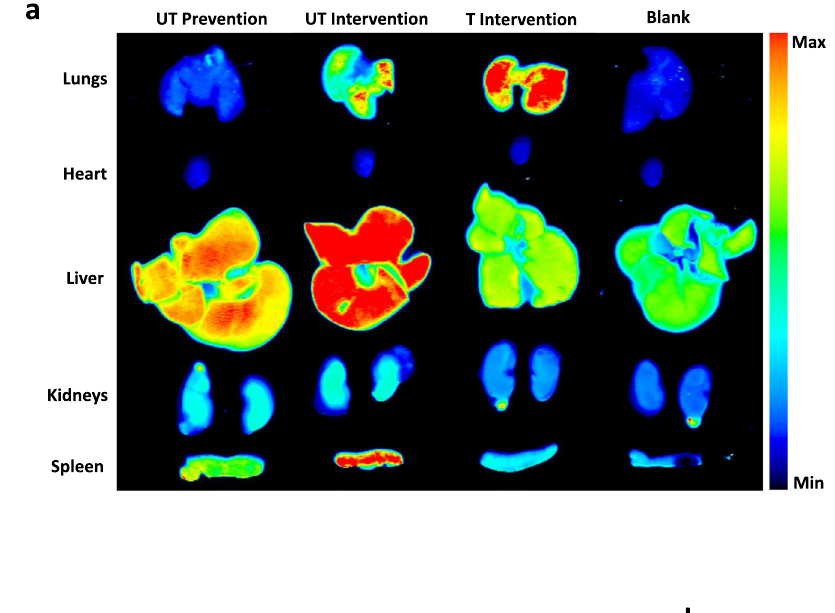
Fig. 4 | Particles reduce lipopolysaccharide (LPS)-induced neutrophil-platelet aggregate adhesion in mouse mesentery. a Timeline, dosing scheme, and experimental schematic of intravital microscopy of in fl amed mouse mesentery. Mice received an intraperitoneal (IP) injection of LPS and a retroorbital (RO) injection of labeling antibodies at t =0, and for particle groups, a RO injection of particlesat t =0( ‘ prevention ’ )or t =2h( ‘ intervention ’ ).Micewereimagedat t =3h after LPS injection. b Representative still image of merged bright fi eld microscopy, fl uorescentBrilliantViolet421Ly6G+neutrophils(blue),FITCpolystyreneparticles (green), anti-GP1b DyLight 649 platelets (red) channels within mouse mesenteric blood vessel for an LPS-only (non-particle treated; left) and untargeted (UT) Pre- vention (right) mouse. Neutrophil, platelet, and particle adhesion were quanti fi ed only within blood vessels, edges of which are denoted with dashed arrows. Small white arrows highlight several platelet-neutrophil aggregates, scale bar 100 µ m. Quanti fi ed results of ( c ) platelet adhesion scaled by the surface area of the blood